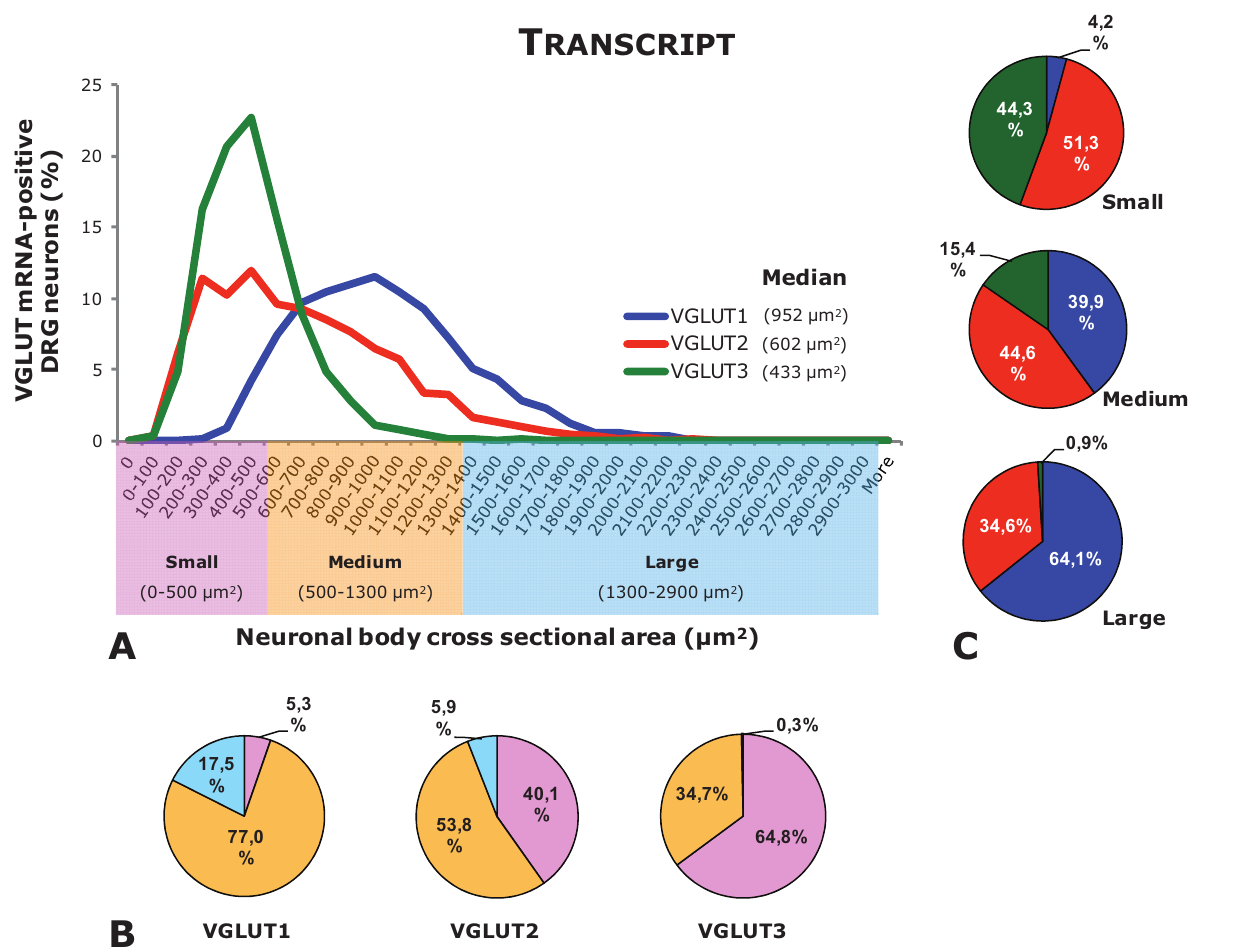
Figure 2. Neuronal size distribution of DRG neurons positive for VGLUT1-VGLUT3 mRNA (based on data from [13]). ( A ) Histogram showing the size distribution of L4-5 DRG neurons expressing the transcript of VGLUT1, VGLUT2, or VGLUT3 (Percentages were obtained comparing cell soma size at each value in “X” with the total number of neurons measured for each VGLUT). ( B ) Pie charts showing the percentage of small, medium-sized, and large DRG neurons relative to each VGLUT. ( C ) Pie charts showing the percentage of VGLUT1-, VGLUT2-, or VGLUT3-positive DRG neurons relative to each neuronal